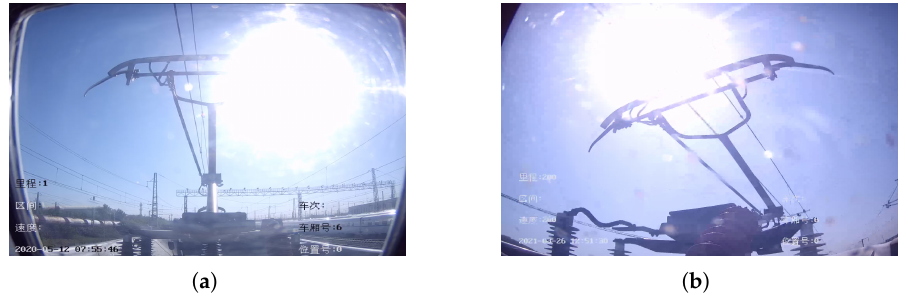
Figure 11. Sun affects pantograph detection. ( a ) HSR-A. ( b ) HSR-B.